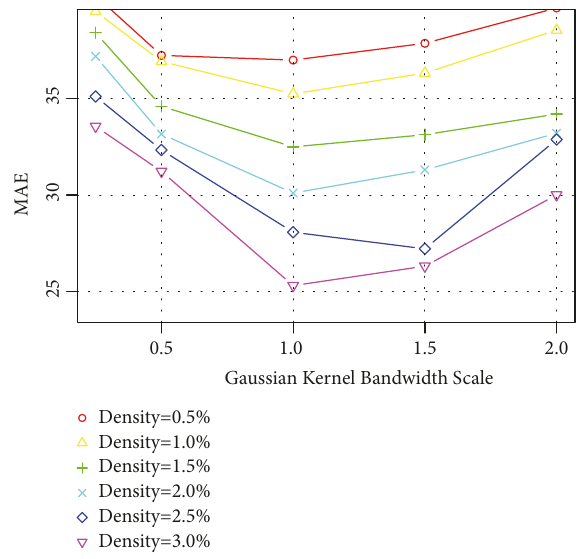
Figure 5: MAE with respect to number of ReLU layers.